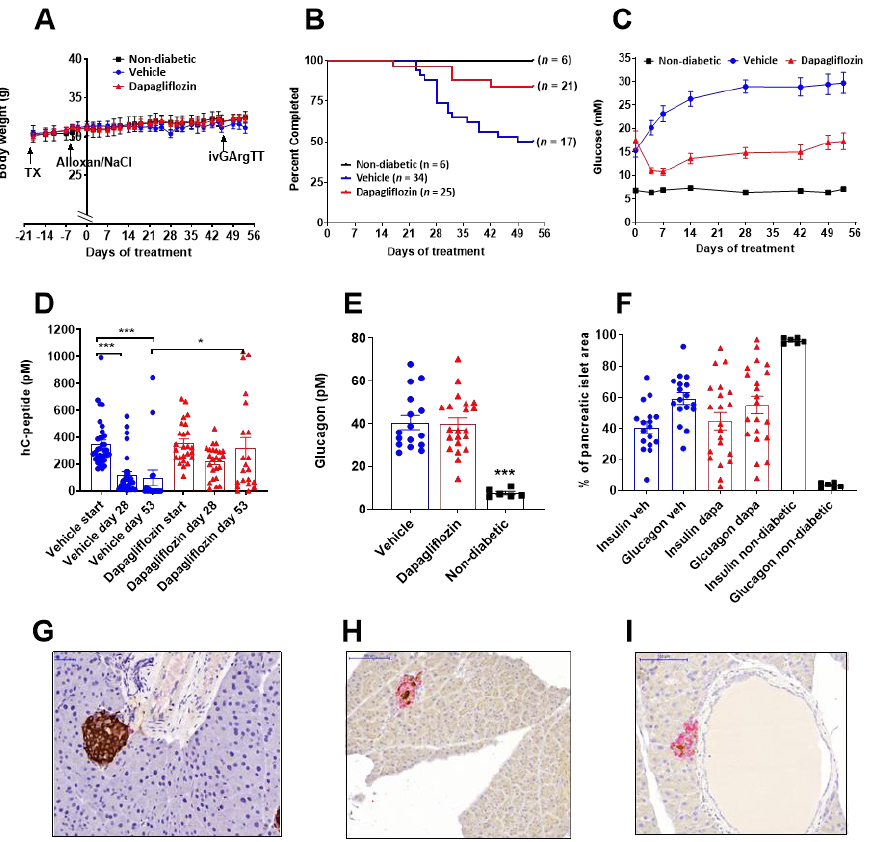
Figure 1. Dapagliflozin increased survival and protected human beta cells in diabetic mice ( A ) Body weight was measured regularly throughout the study. The mice were transplanted (TX) with ~1500 human islet equivalents two weeks before alloxan ablation of the mouse beta cells. Dapagliflozin was given in the drinking water for 8 weeks starting day 0. The diabetic control mice were given tap water. Sham-operated mice with no transplant and no alloxan treatment were used as normoglycemic controls. ( B ) Survival plot over the 8-week study. A total of 59 mice were transplanted with human islets, and 38 mice completed the study. ( C ) Fed glucose values and ( D ) human C-peptide levels measured before dapagliflozin treatment start and after 28 and 53 days. ( E ) Plasma glucagon levels measured at termination. ( F ) Distribution of alpha cells and beta cells in the mouse pancreas in the different treatment groups. Mouse pancreatic islet stained for insulin (brown) and glucagon (purple) in ( G ) nor- moglycemic control mice, ( H ) vehicle-treated alloxan-diabetic mice, and in ( I ) dapagliflozin-treated alloxan-diabetic mice. The data are presented as mean, and error bars represent SEM. * p < 0.05, *** p < 0.001. Statistical difference was determined using one-way ANOVA followed by Tukey’s post- hoc test and two-way ANOVA for repeated measures. Number of samples were n = 21 (dapagliflozin, red symbols), n = 17 (vehicle, blue symbols) and n = 6 (sham, black symbols) representing animals that completed the